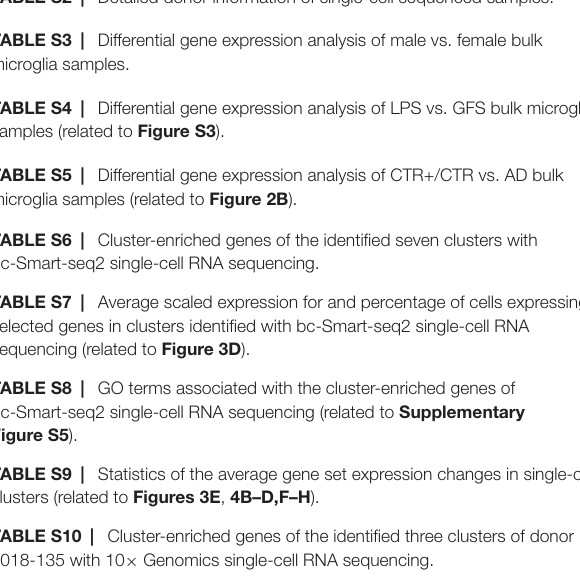
TABLE S1 | Detailed donor information of bulk sequenced samples. TABLE S2 | Detailed donor information of single-cell sequenced samples.